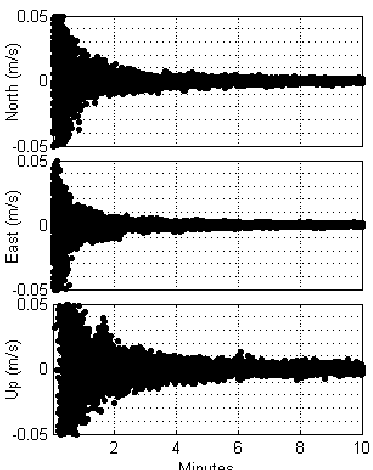
Figure 3. Coordinate rate of change (CROC) for all datasets used in this study. CROCs from 44 hourly datasets were plotted for the first 10 min.